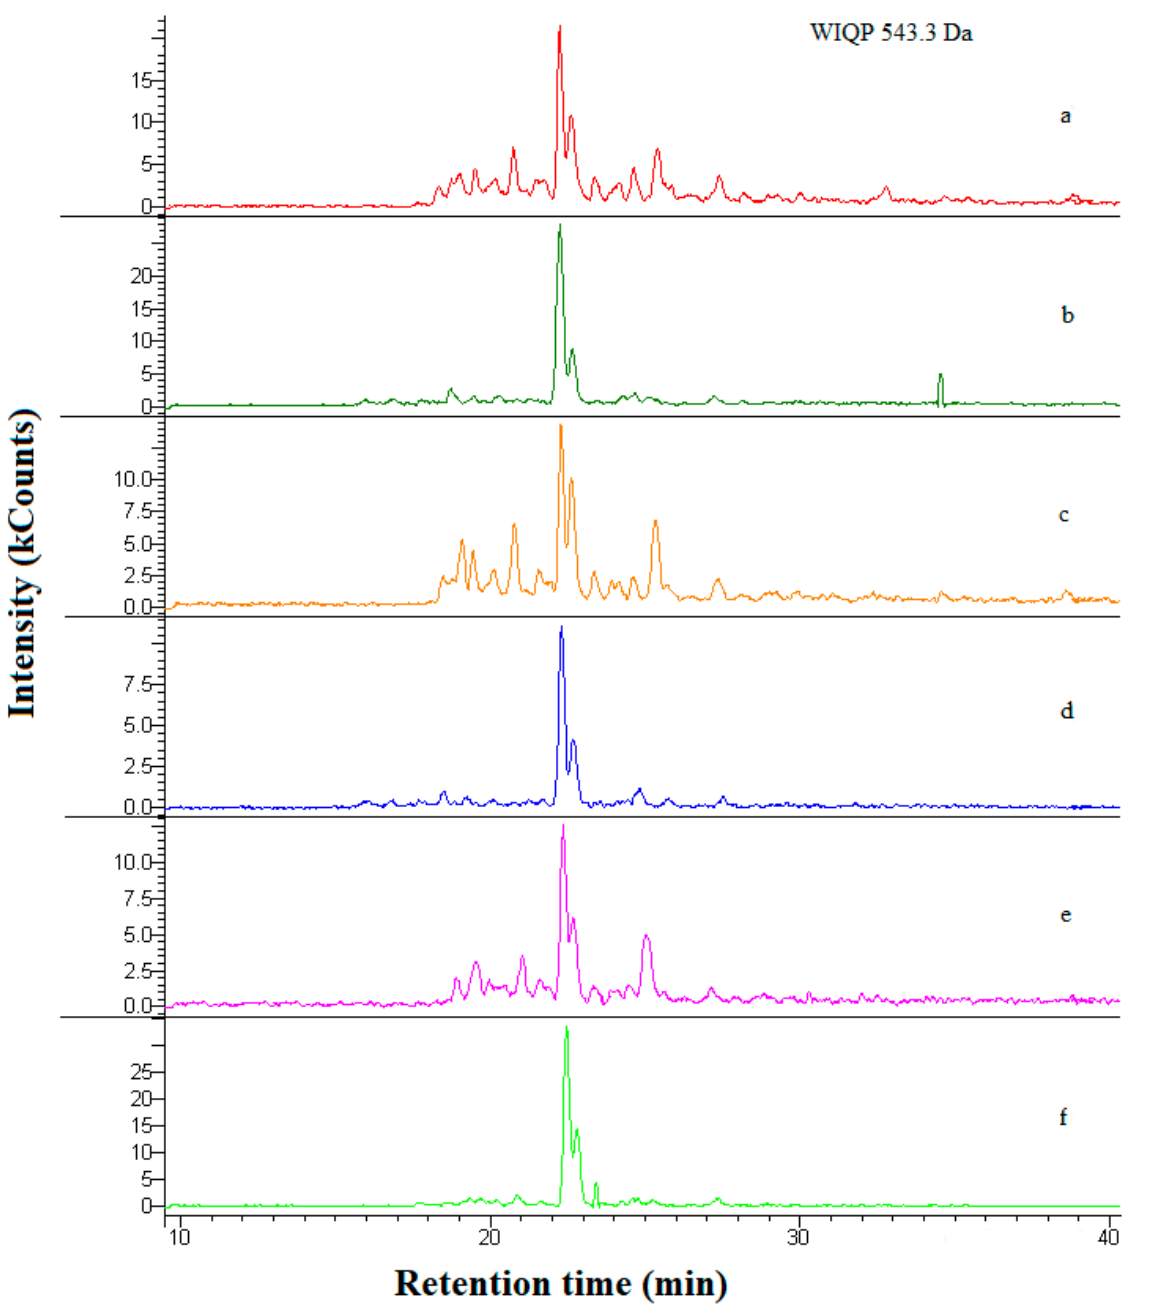
Figure 2. An example of an RP-HPLC-MS/MS chromatogram of the WIQP peptide acting as a DPP-IV inhibitor identified in all Gouda cheese variants. Samples derived from: ChCN ↓ -1 ( a ), ChCN ↓ -60 ( b ), ChCN-0-1 ( c ), ChCN-0-60 ( d ), ChCN ↑ -1 ( e ), ChCN ↑ -60 ( f ), respectively. Abbreviations: ChCN ↓ -1, ChCN ↓ -60, ChCN-0-1, ChCN-0-60, ChCN ↑ -1, ChCN ↑ -60—water-soluble extracts derived from Gouda cheese with: reduced ( ↓ ), normative (0), and increased ( ↑ ) content of β -casein after 1 (suffix 1) and 60 (suffix 60) days of ripening, respectively.